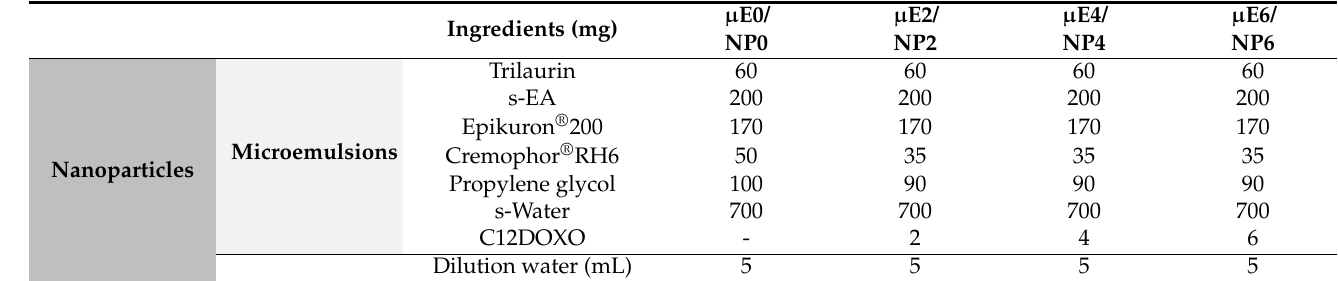
Table 1. Composition of microemulsions and